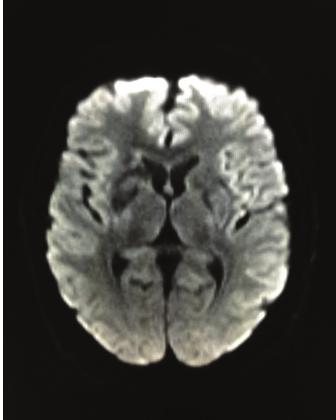
Figure 5: Coronal T1 postcontrast demonstrates enhancement in the left putamen and right caudothalamic